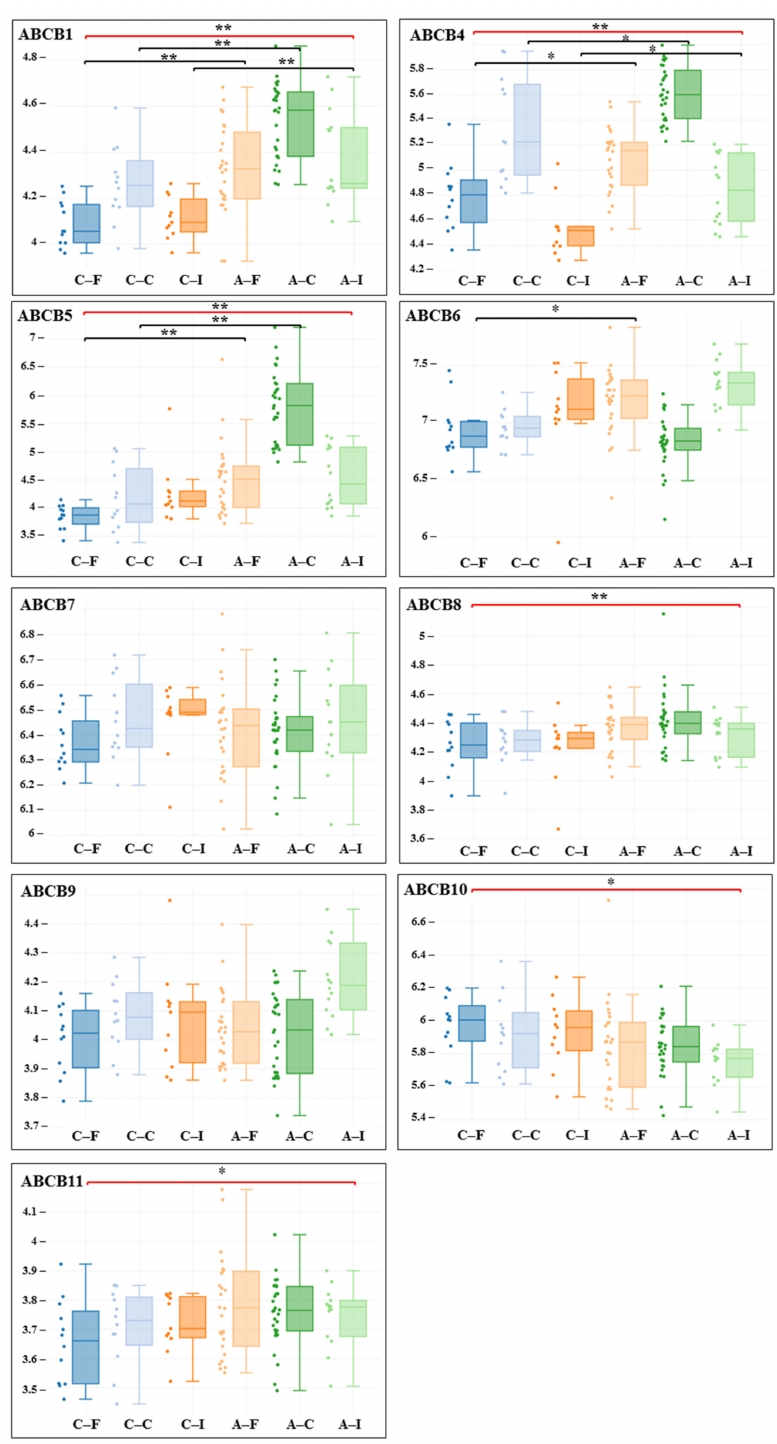
Figure 2. Gene expression patterns of the ABCB subfamily in the comparison groups: atherosclerotic— femoral artery (A–F); atherosclerotic—carotid artery (A–C); atherosclerotic—infra-popliteal artery (A–I); control—femoral artery (C–F); control—carotid artery (C–C); control—infra-popliteal artery (C–I). The red line shows the differences in gene expression in the group between all sets with atherosclerosis and all control sets. The data distribution is visualized in the form of box diagrams. Statistically significant differences ( p values adjusted using the algorithm of Benjamini–Hochberg (adj. P. Val)) shown with asterisks: * p < 0.05, ** p <